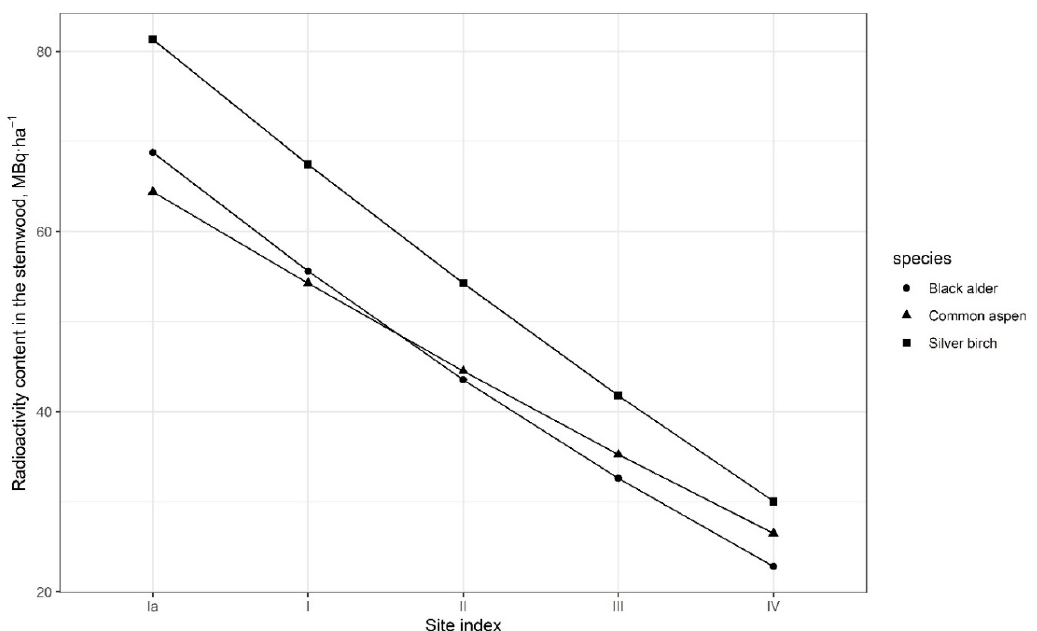
Figure 3. Dependence of the 90 Sr activity stock in stemwood (at 40 kBq · m − 2 in soil and stands age 60 years) on various site index of forest stands.